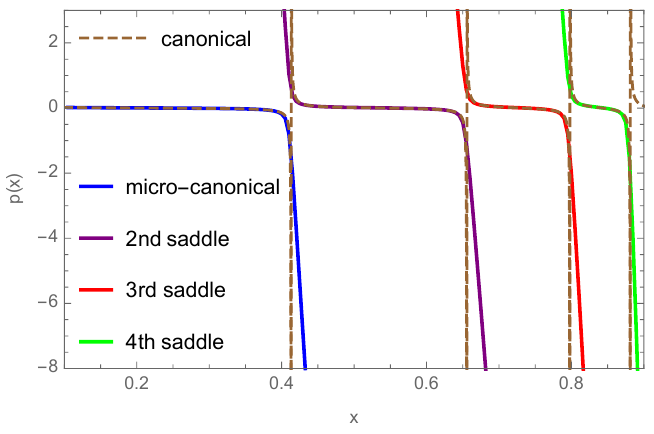
3 ; x ) from various saddles (solid) of the inverse-Laplace Figure 7 . Plots of p ( (cid:15) H = 36 ; (cid:15) L = 10 (cid:0) transformationt; compared against the canonical result (dashed).